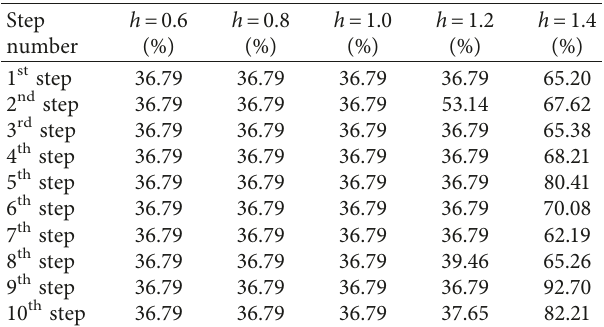
Table 9: Accuracy maintaining reliability at different accuracy thresholds for subseries X 4